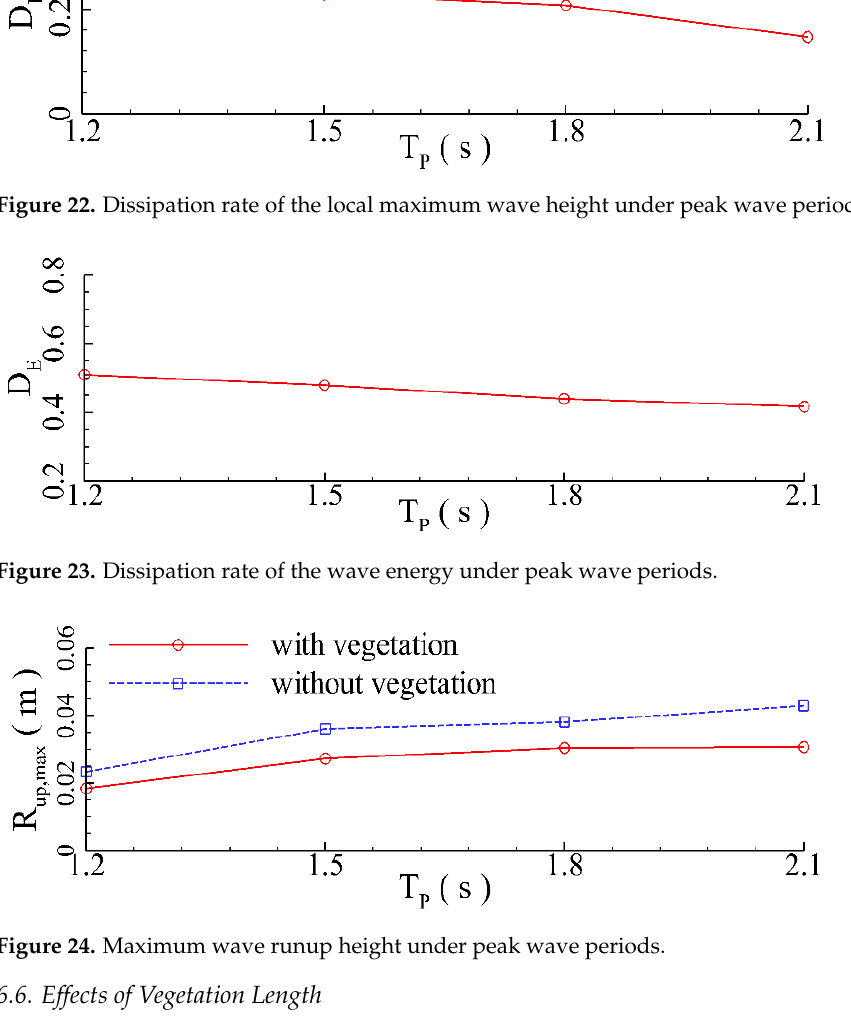
Figure 24. Maximum wave runup height under peak wave periods.